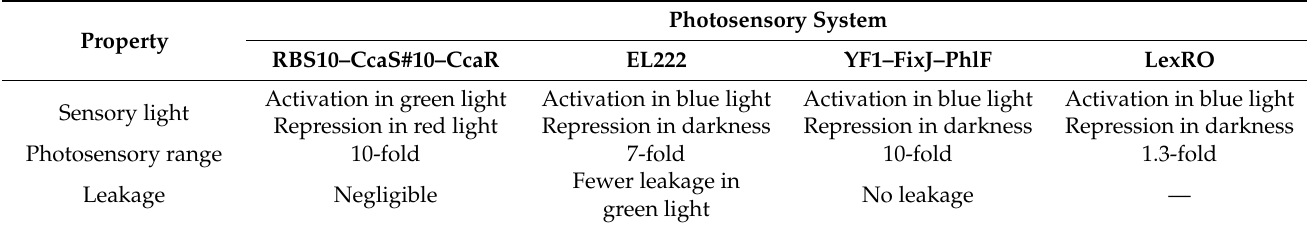
Table 1. Characteristics of various photosensory